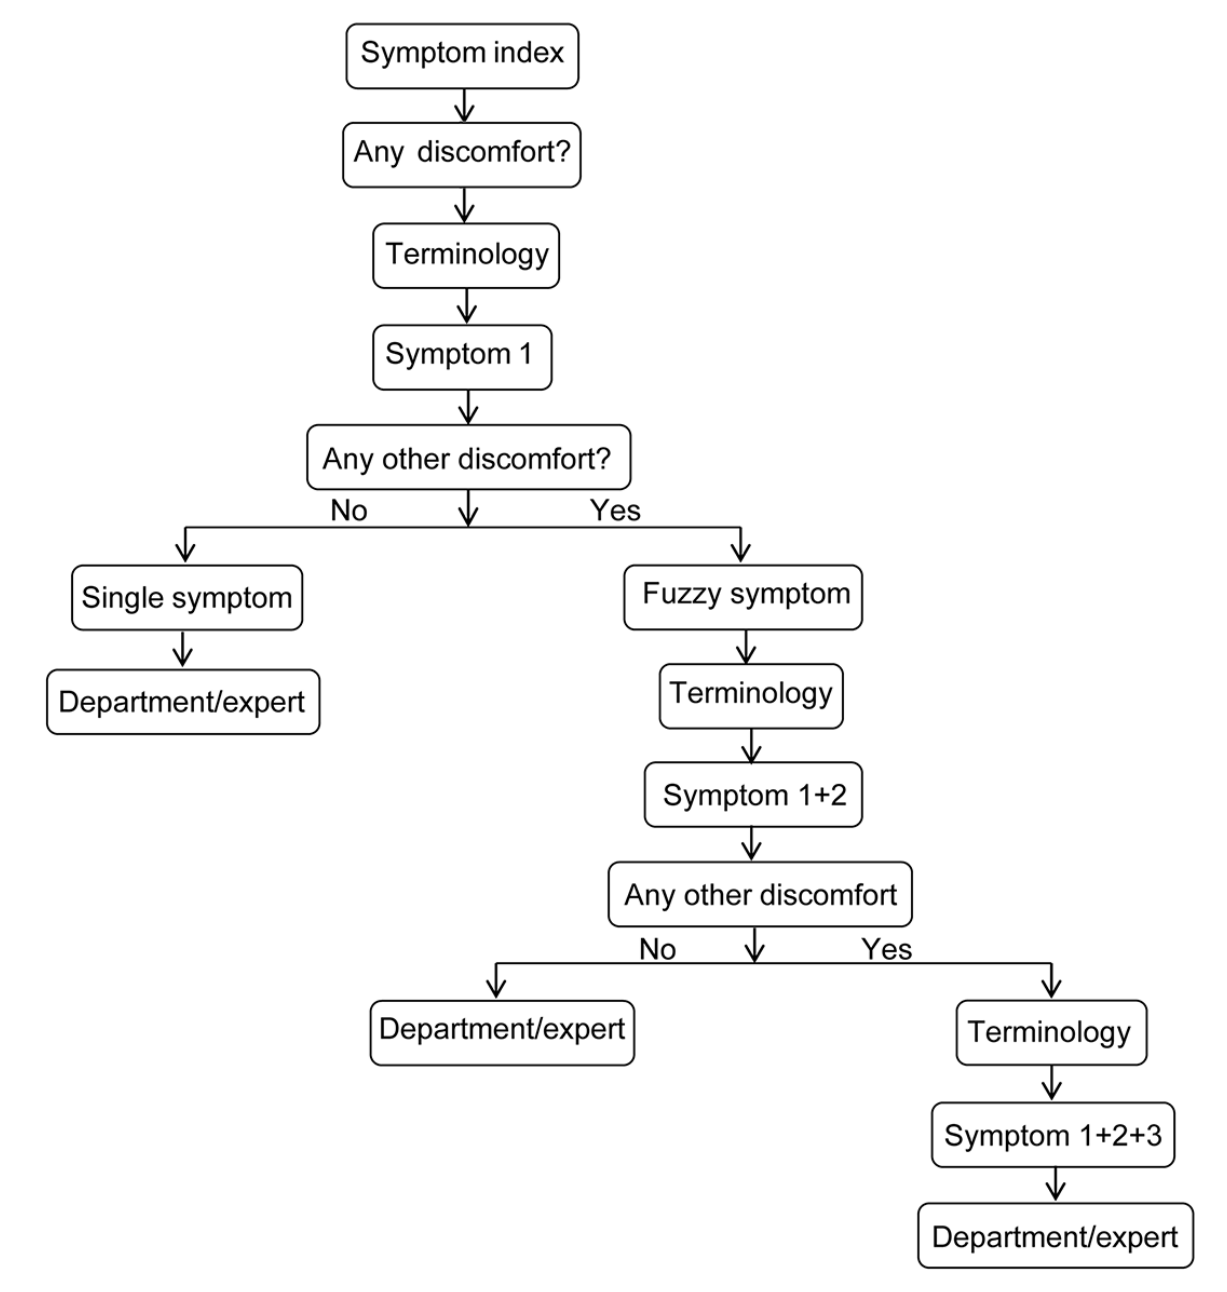
Figure 1. Self-appointment symptom index